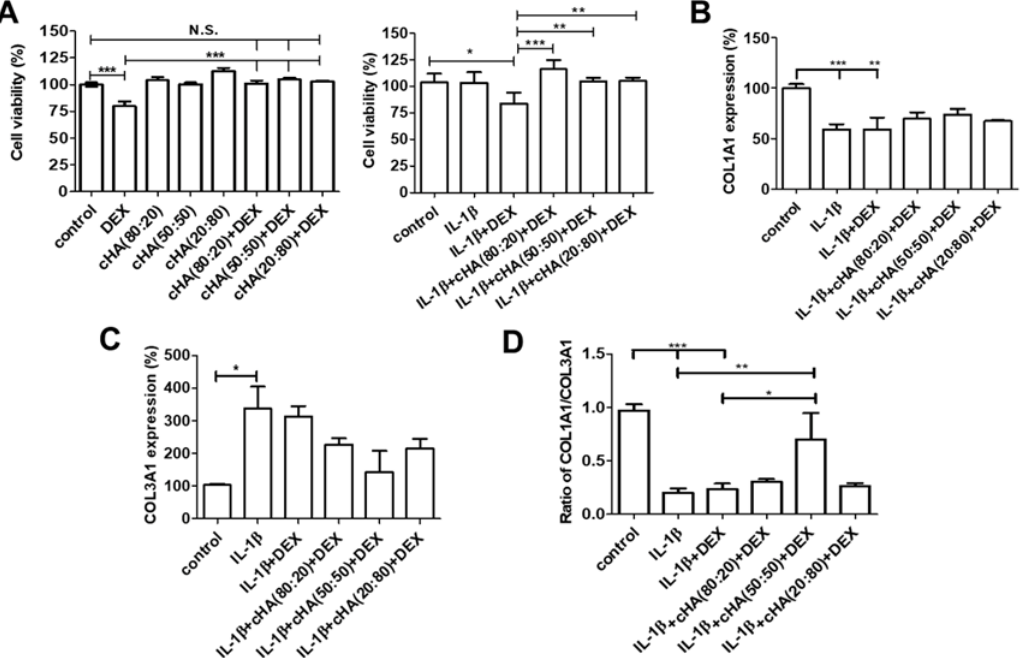
Figure 1. Effects of various combinations of cross-linked hyaluronate (cHA) with dexamethasone (DEX) in cell viability and interleukin-1 (IL)-1 β -stimulated gene expression. Human primary tenocytes were treated with different formulations of cHA (cHA: linearized HA = 80:20, or 50:50, or 20:80, at the concentration of 2.5 mg/mL), DEX (100 µ M), and combinations of cHA with DEX (100 µ M) in response to IL-1 β (1 ng/mL) stimulation. ( A ) Cell viability was determined by WST-8 analysis. Data were represented as the percentages normalized with the average WST-8 values read at an absorbance of 450 nm of the control group and expressed as mean ± SEM. Relative expression of ( B ) COL1A1 ( C ) COL3A1 was determined by quantitative reverse transcription polymerase chain reaction (qRT-PCR). ( D ) The ratio of COL1A1/COL3A1 was shown among each group. Values are the mean ± SEM ( n = 3 – 8). * p < 0.05, ** p < 0.01, *** p < 0.001.